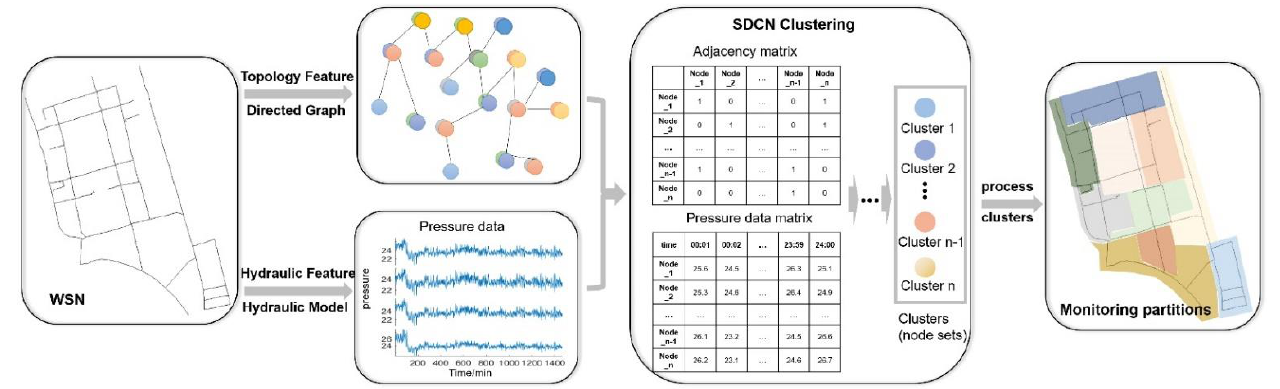
Figure 2. Monitoring partition establishment.